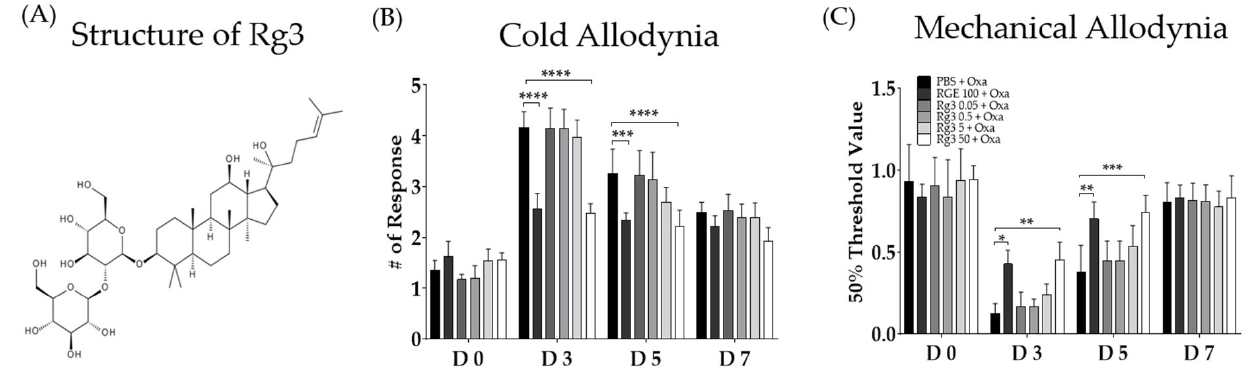
Figure 5. Dose-dependent preventive effects of ginsenoside Rg3 on the cold and mechanical forms